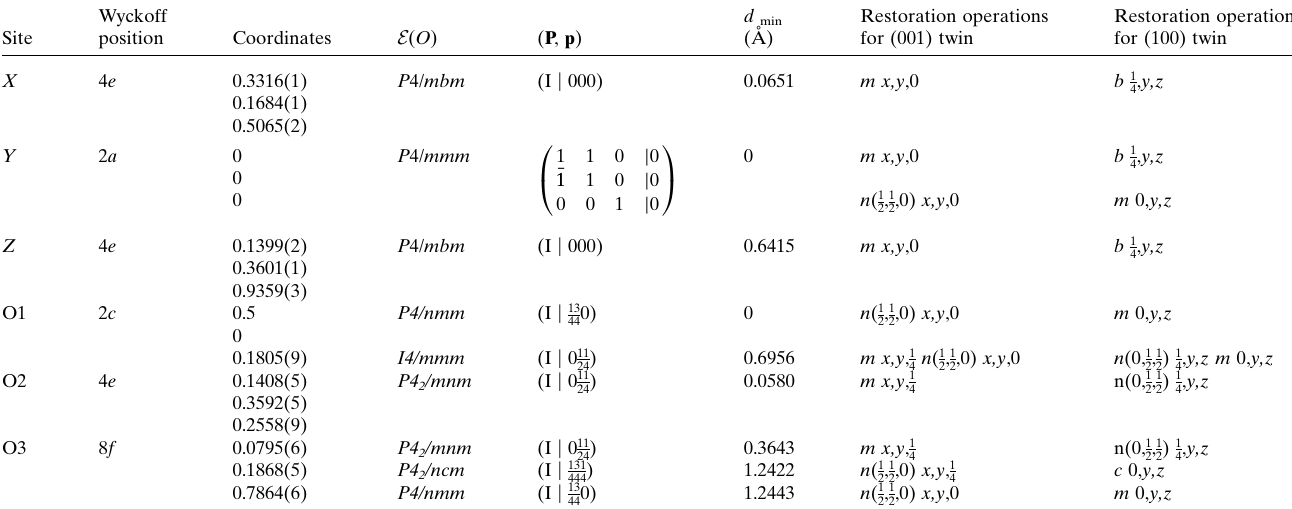
Table 1 Atomic coordinates of melilite (after Bindi & Bonazzi, 2005) and analysis of the quasi-restoration of each orbit. The orbit (pseudo)-eigensymmetry is given as the minimal distance between atoms quasi-restored by the twin operations. This distance coincides with the degree of pseudo-symmetry ( (cid:3) max ) obtained by PSEUDO (Capillas et al. , 2011) as the maximal distance between atoms produced by the additional symmetry operations of Eð O Þ . ( P , p ) is the matrix-column pair relating the coordinate system of G to that of Eð O Þ . The restoration operations are given with respect to the coordinate system of G